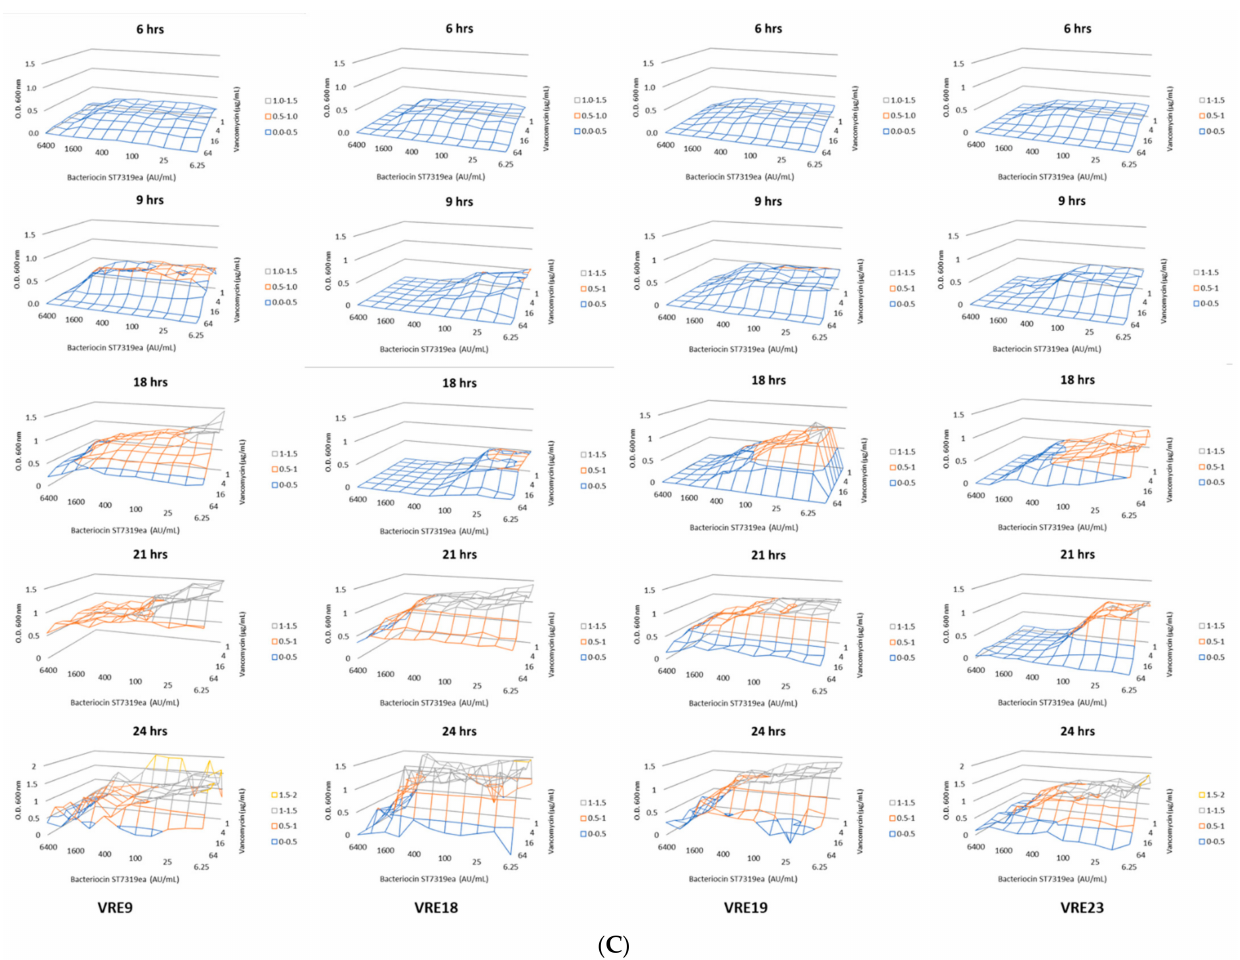
Figure 4. Viability test of VRE strains ( E. faecium VRE9, E. faecium VRE18, E. faecium VRE19, and E. faecium VRE23, as indicated) by spectrophotometry. VRE strains were challenged with different concentrations of vancomycin (1.0 to 64 µ g mL − 1 ) and bacteriocins produced by ( A ): P. acidilactici ST3522BG, ( B ): P. pentosaceus ST3633BG, and ( C ): E. faecium ST7319ea (6.25 to 6400 AU mL − 1 ). Cultures were incubated for 24 h and analyzed at 6, 9, 18, 21, and 24 h by spectrophotometry, as indicated on the